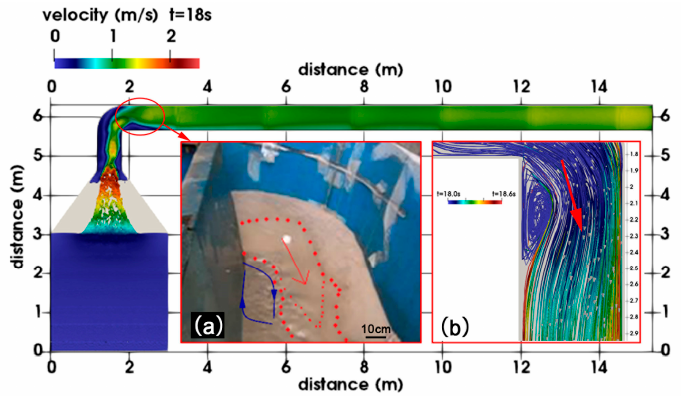
Figure 4. Comparison between the numerical and experimental snapshots of slurry flow at the sharp bend: ( a ) experimental result; ( b ) numerical particle trajectories.